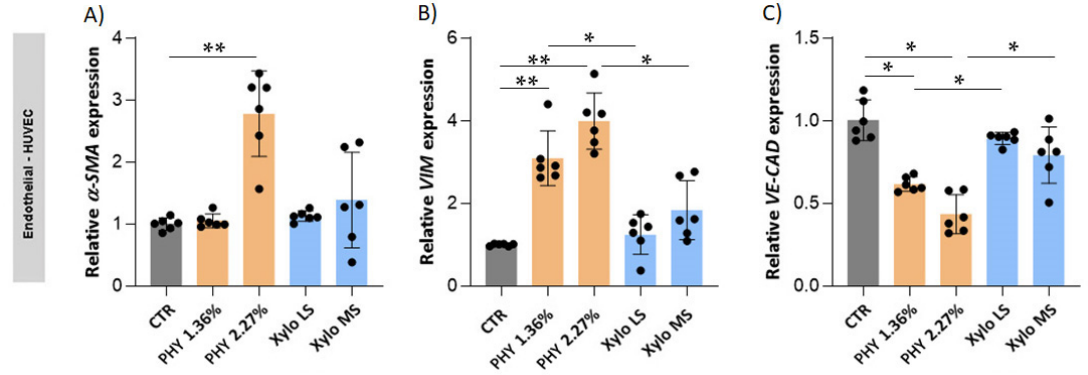
Figure 7. Expression of endothelial and mesenchymal markers in endothelial cells. α -SMA ( A ), VIM ( B ) and VE-CAD ( C ) gene expression. The analysis was performed in HUVEC endothelial cells as described in Figure 5, Graphs represent mean ± standard deviation (error bars)( n = 6 biological replicates) ( A ) CTR vs. PHY 2.27% p < 0.0001, ( B ) CTR vs. PHY 1.36% p < 0.0001, CTR vs. PHY 2.27% p < 0.0001, PHY 1.36% vs. Xylo LS p = 0.0086, PHY 2.27% vs. Xylo MS p = 0.0023, ( C ) CTR vs. PHY 1.36% p = 0.0019, CTR vs. PHY 2.27% p = 0.0016, PHY 1.36% vs. Xylo LS p = 0.0013, PHY 2.27% vs. Xylo MS p = 0.0036 * p < 0.05, ** p < 0.001.